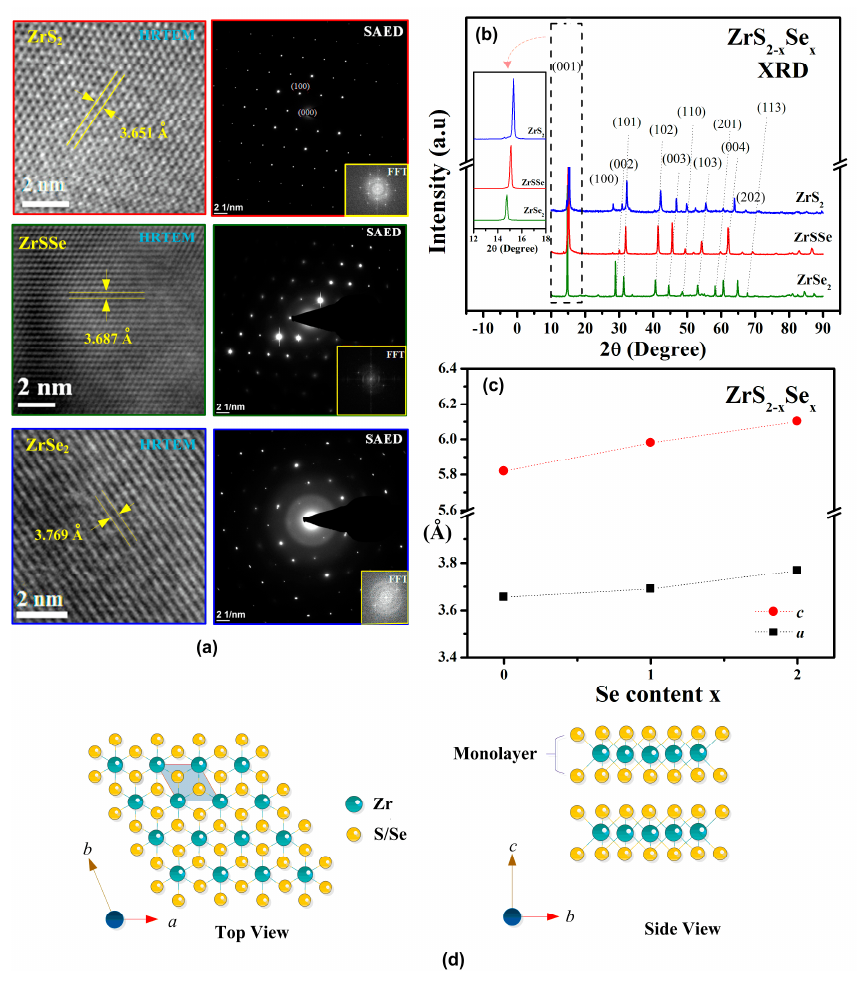
Figure 1. ( a ) High-resolution transmission electron microscope (HRTEM) results, selected-area-electron-diffraction (SAED), and FFT images of ZrS 2 , ZrSSe, and ZrSe 2 . ( b ) XRD pattern of ZrS 2-x Se x (x = 0, 1, and 2). ( c ) Selenium doping effect on the variation of lattice constants a and c . ( d ) Atomic arrangements of layered ZrX 2 (X = S, Se) observed from top view and side view. Energy dispersive X-ray (EDX) spectroscopy is carried out to estimate stoichiometric content